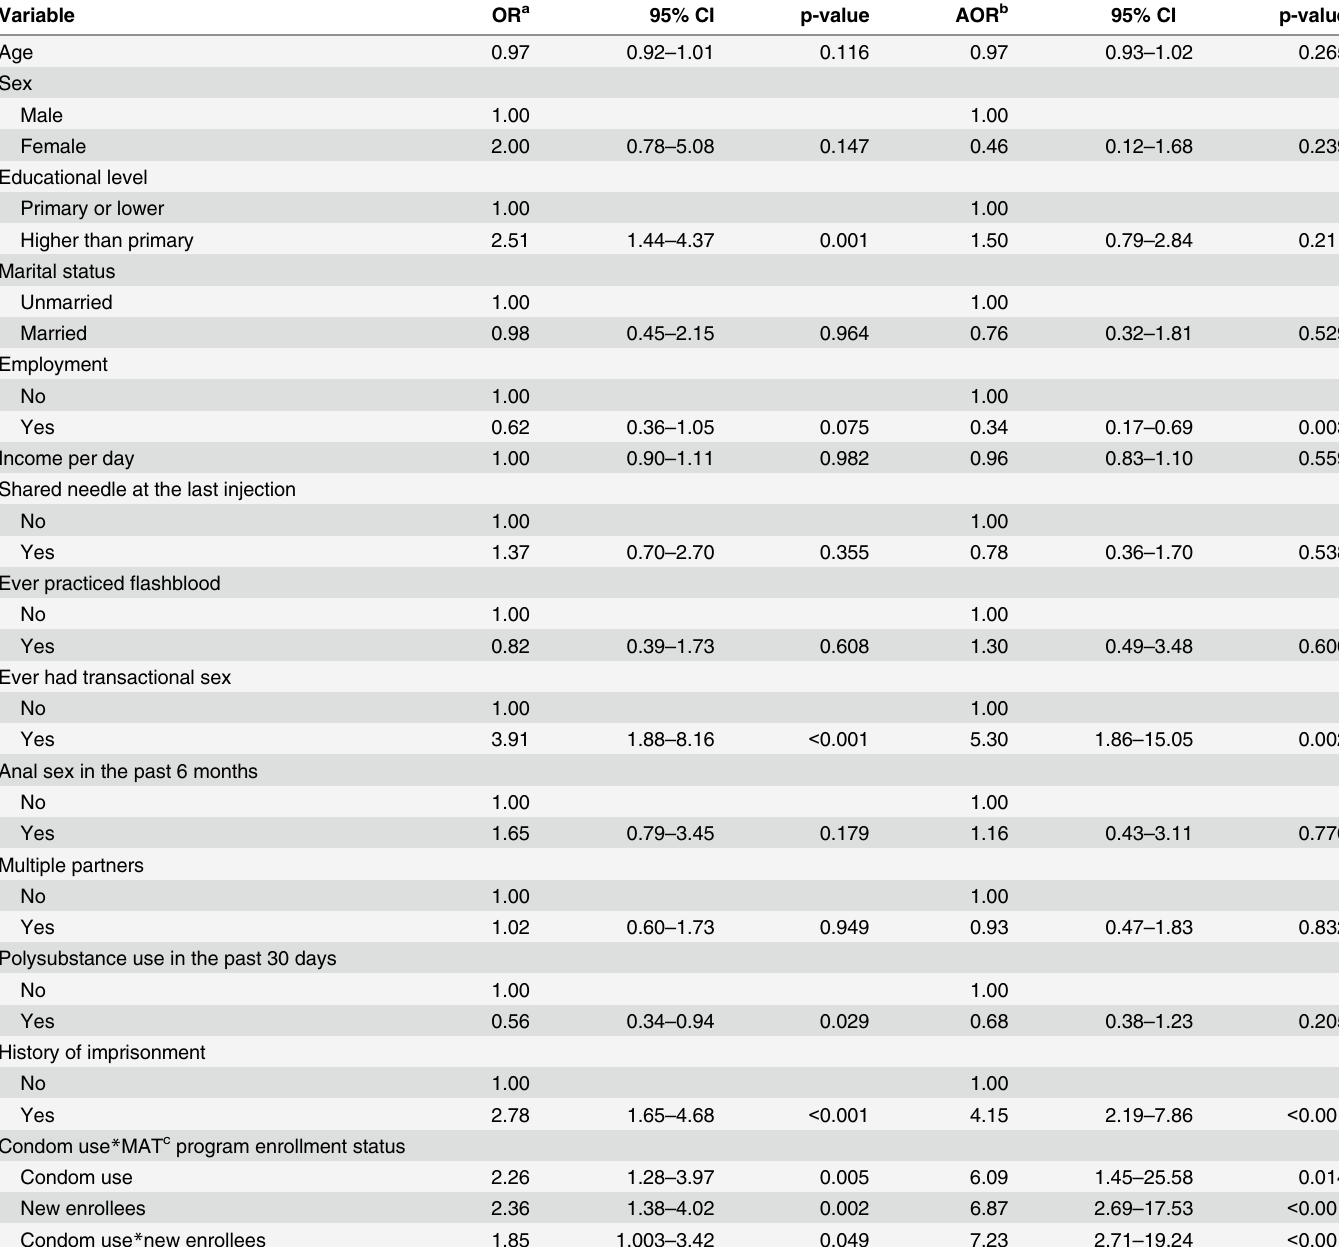
Table 4. Factors associated with ever being screened for hepatitis B/C among